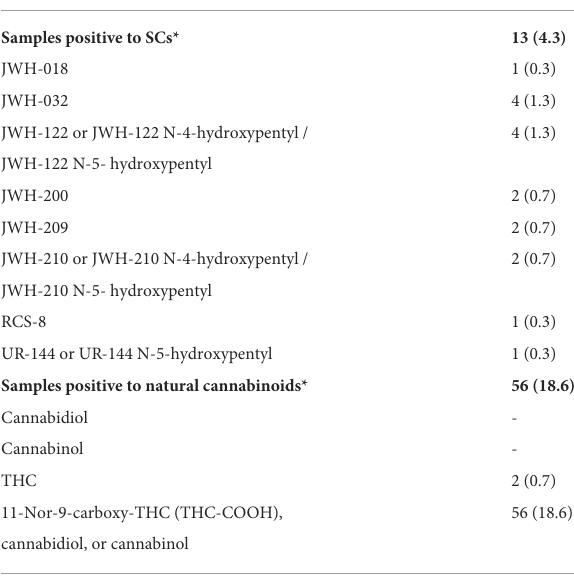
TABLE 1 Cannabis-related substances and metabolites detected among opioid use disorder urine samples ( N =